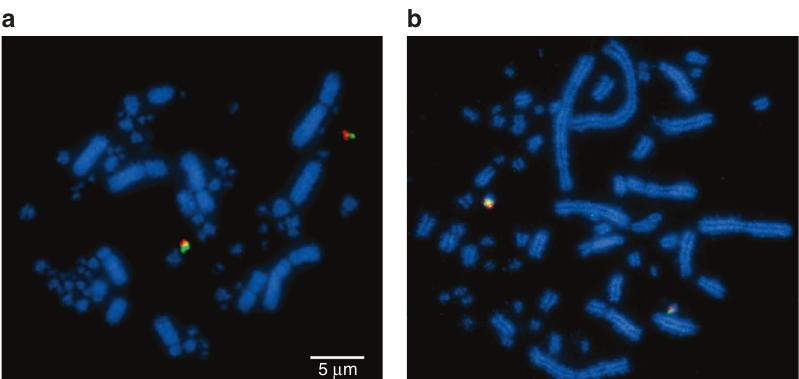
Fig. 1 Cross-species hybridisation (zoo-FISH) results. Hybridisation of chicken chromosome 23 sub-telomeric BACs to a chicken (2 n = 78) and b turtle ( Apalone spinifera 2 n = 66) metaphases. This is an example of how most chromosomes studied in birds and turtles (species examined with the highest diploid number) are precise counterparts of one another. All syntenic chromosomes were of similar sizes and morphologies. All chromosomes are labelled in blue (DAPI) with BAC probes labelled in red (Texas Red) and green (FITC), respectively (where signals overlap a little, a yellow/orange colour is seen). Successful strong hybridisation across large evolutionary distances was one of the technical advances of this project. Scale bar applies to